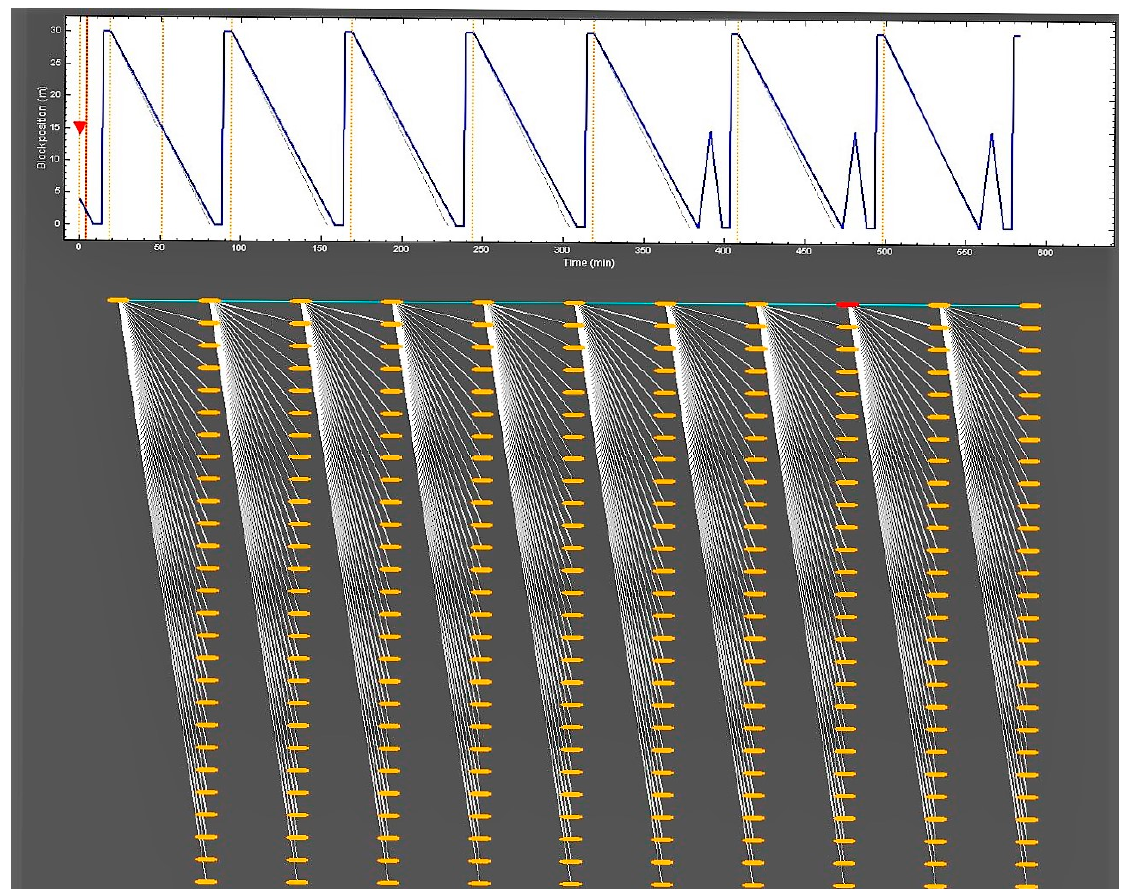
Figure 10. A drilling plan. The top graph shows the block position evolution corresponding to a sequence of actions. In this example, the 4 first stands are drilled with some pace reduction, while the three last ones also include some reciprocation sequence.